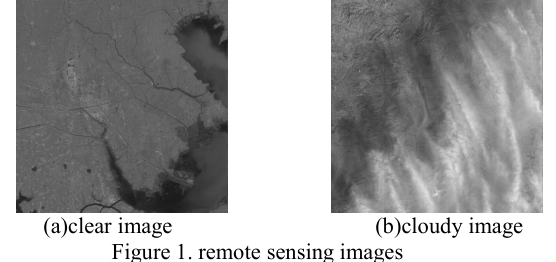
Figure 1. remote sensing images